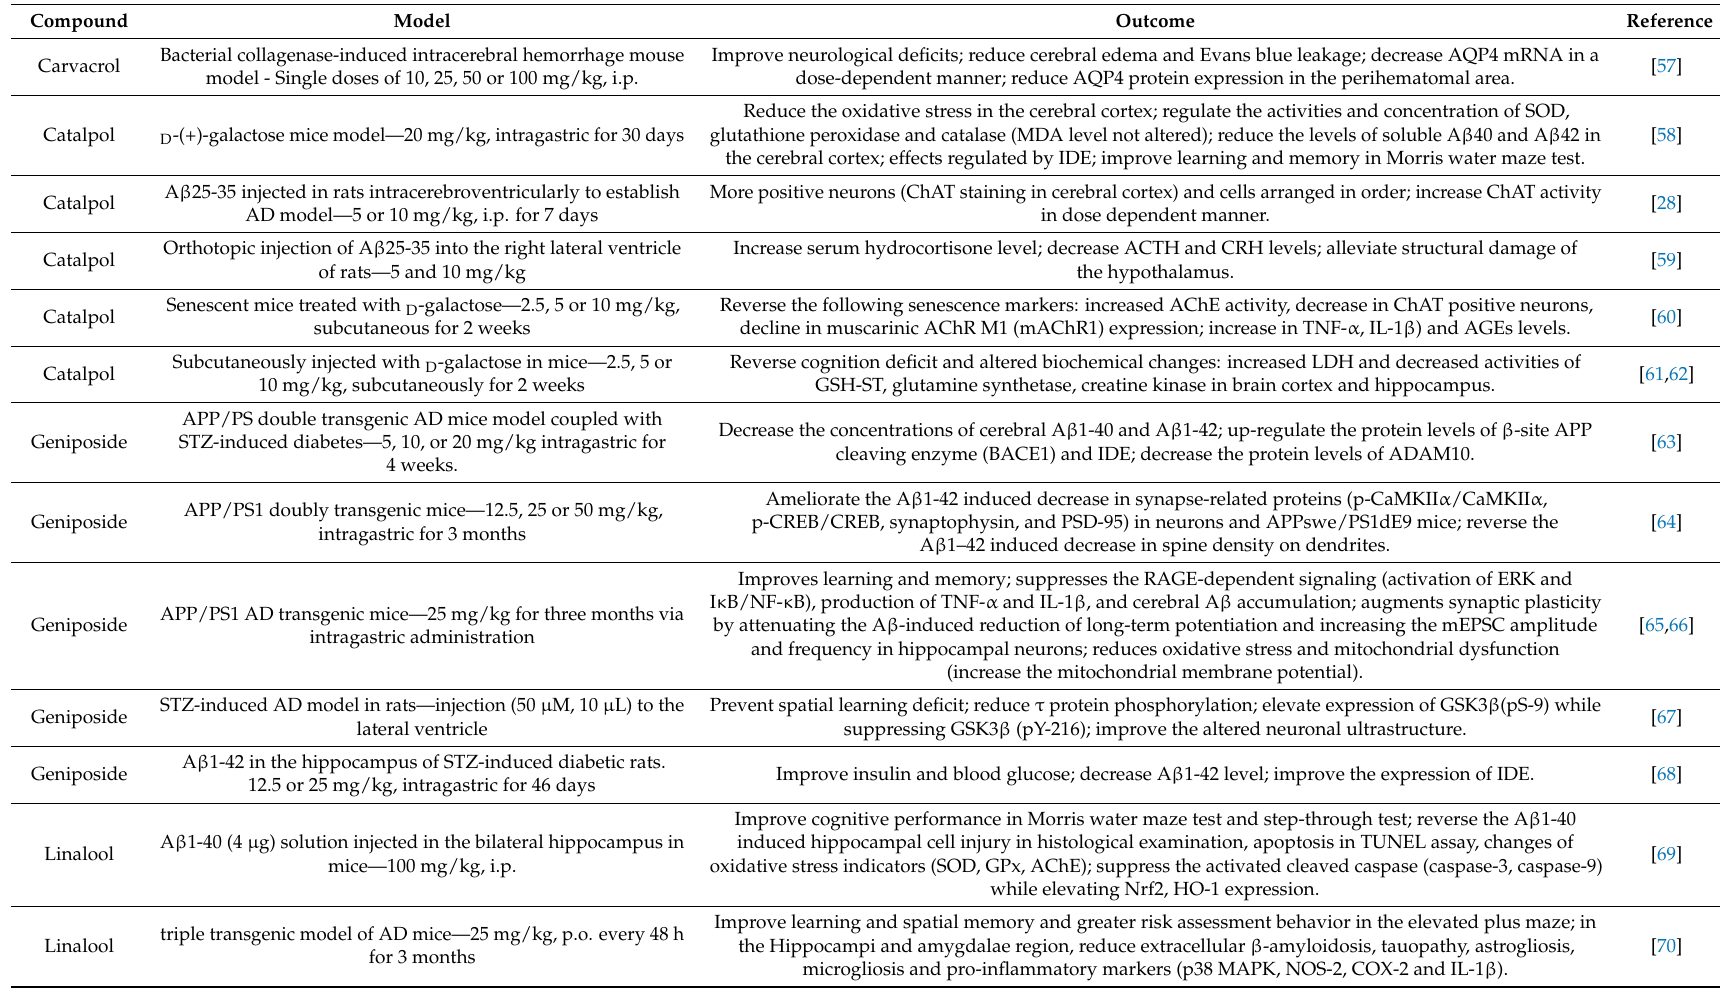
Table 2. In vivo effects of iridoids and some other monoterpenes as potential modulators of